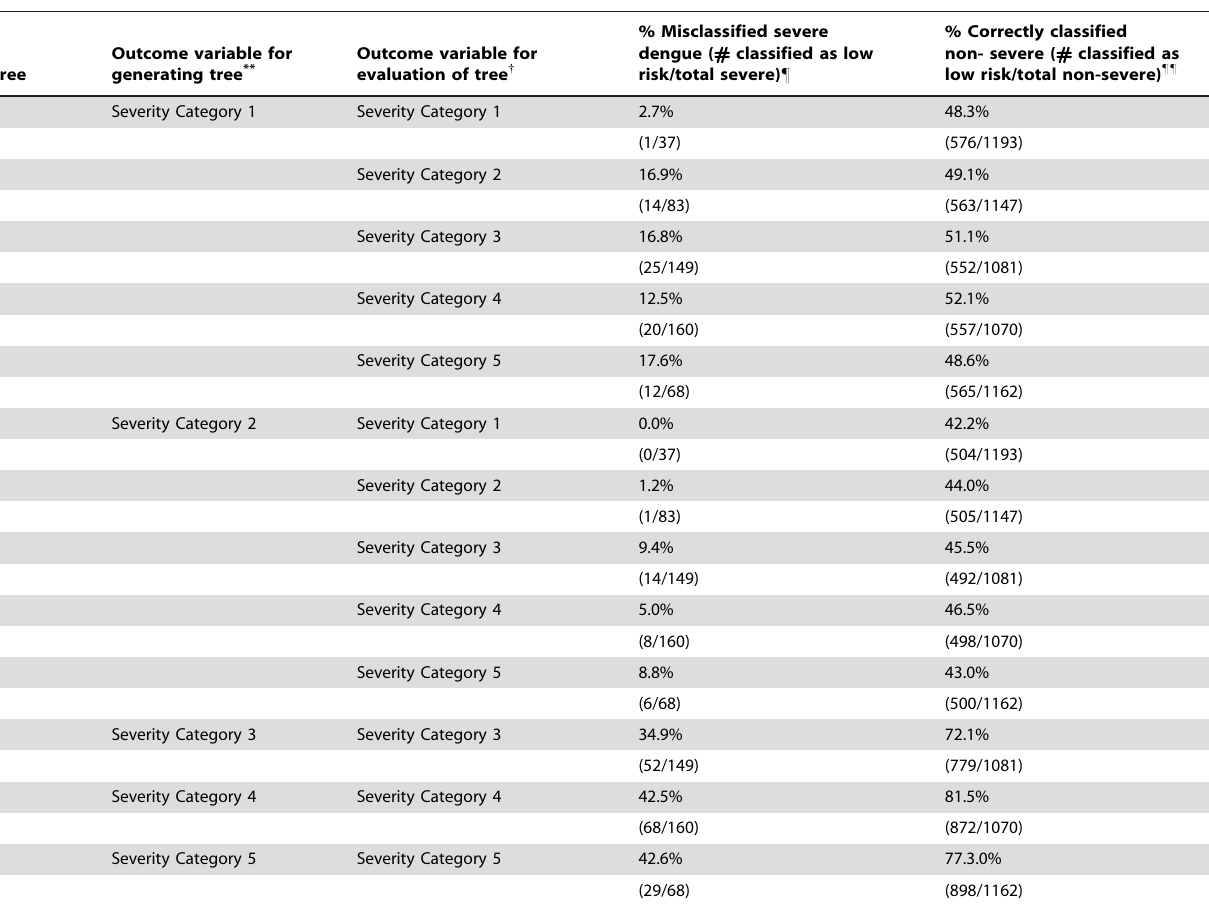
Table 2. CART analysis using different categories of severe dengue illness.*